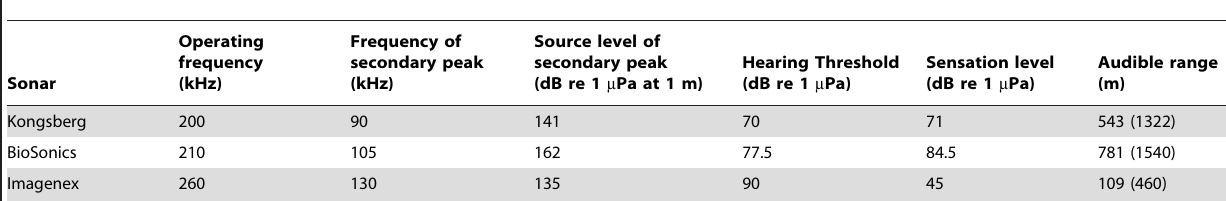
Table 1. Estimated effective root-mean-square source level of the secondary frequency and the resulting distance over which these signals would be audible assuming spherical spreading in seawater (values assuming cylindrical spreading shown in